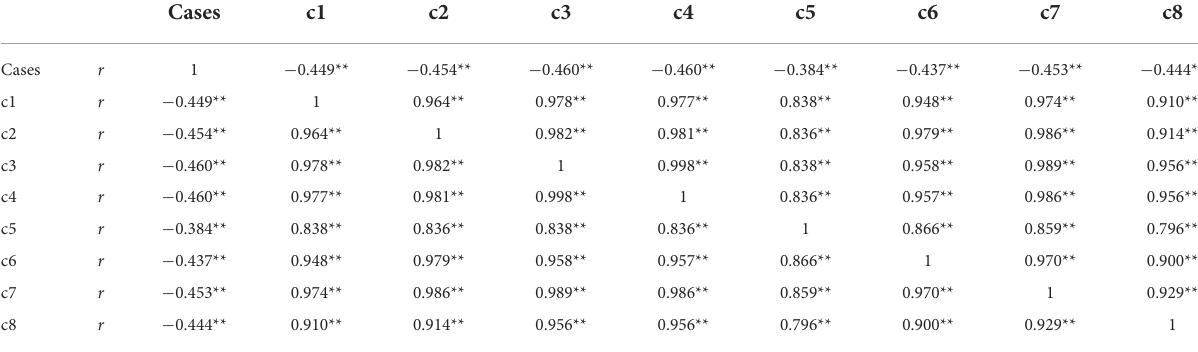
Eight specific NPIs in OxCGRT’s containment and closure policy: school closures (c1), workplace closures (c2), cancellation of public events (c3), restrictions on public gatherings (c4),